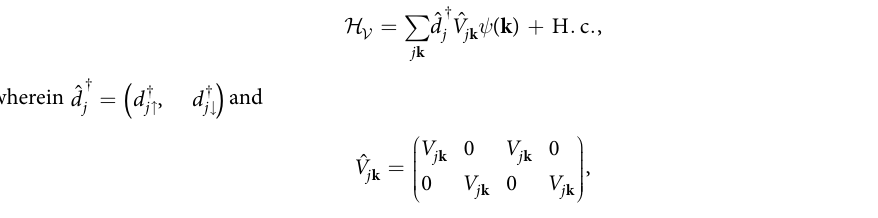
the number of electrons with spin projection σ at the site j with † σ d